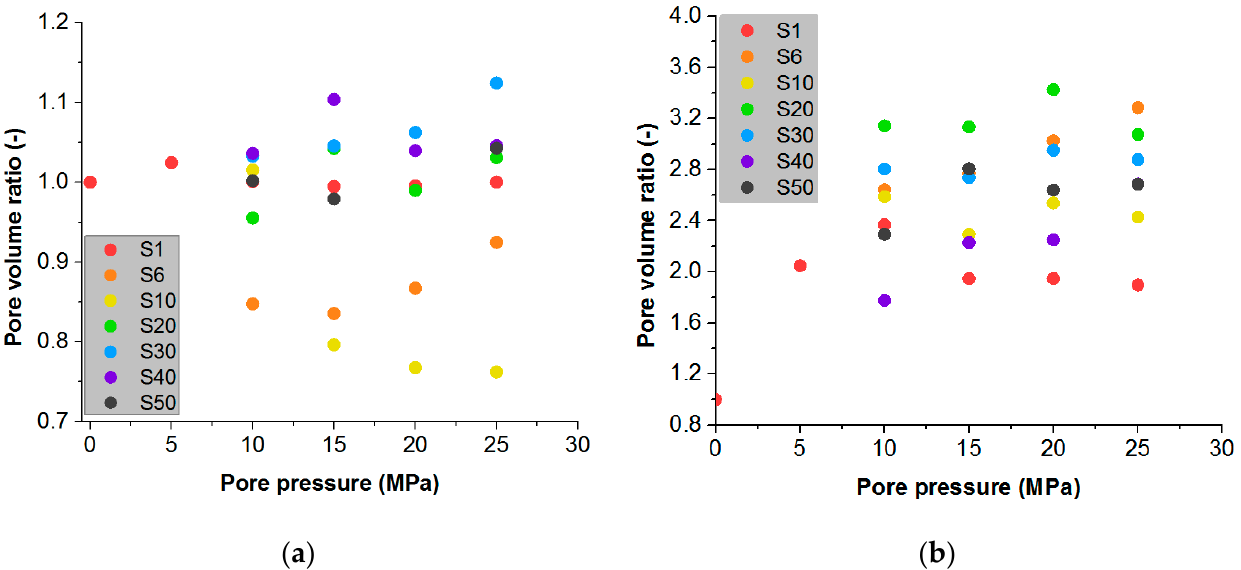
Figure 12. Volume ratio of medium pores ( a ) and large pores ( b ) during the pore pressure increase process after different cycles of fluid injection–production.